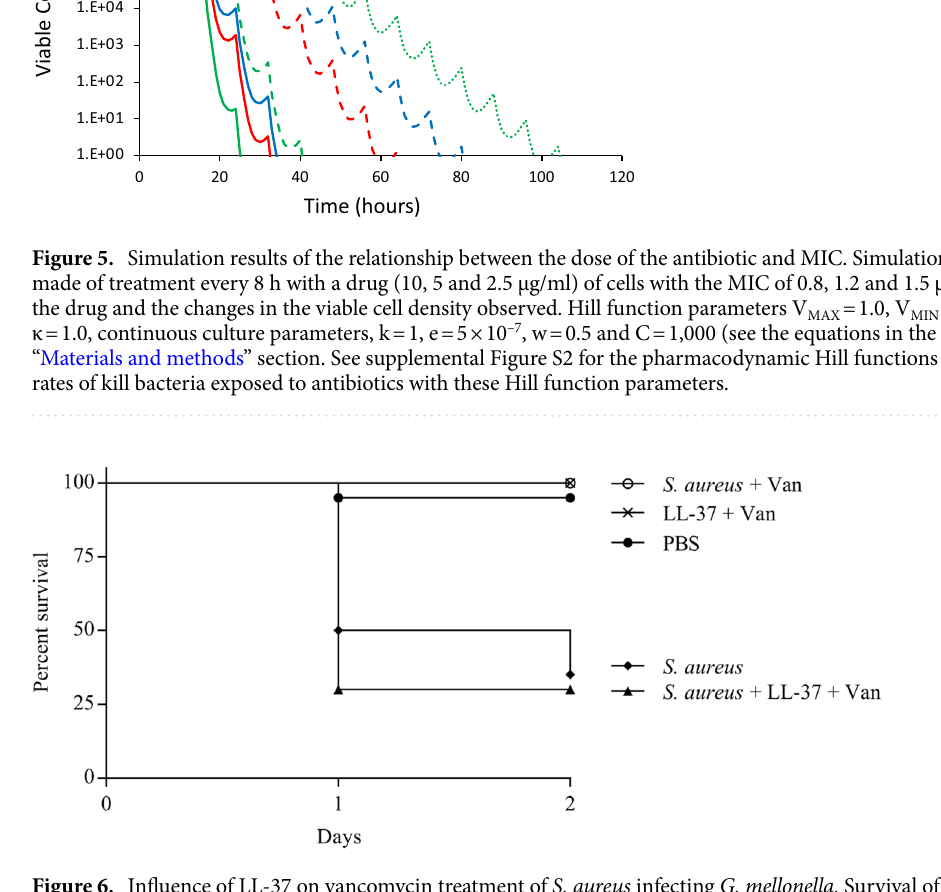
Figure 6. Influence of LL-37 on vancomycin treatment of S. aureus infecting G. mellonella. Survival of G. mellonella wax moth larvae infected with S. aureus FPR3757 and with or without LL-37 (10 µg/ml) exposure followed by treatment with vancomycin (15 mg/kg bodyweight). Controls for non-treated S. aureus infection and non-infected larvae exposed to combinations of the drugs were included. All larvae received same number of injections. n = 20 larvae for each